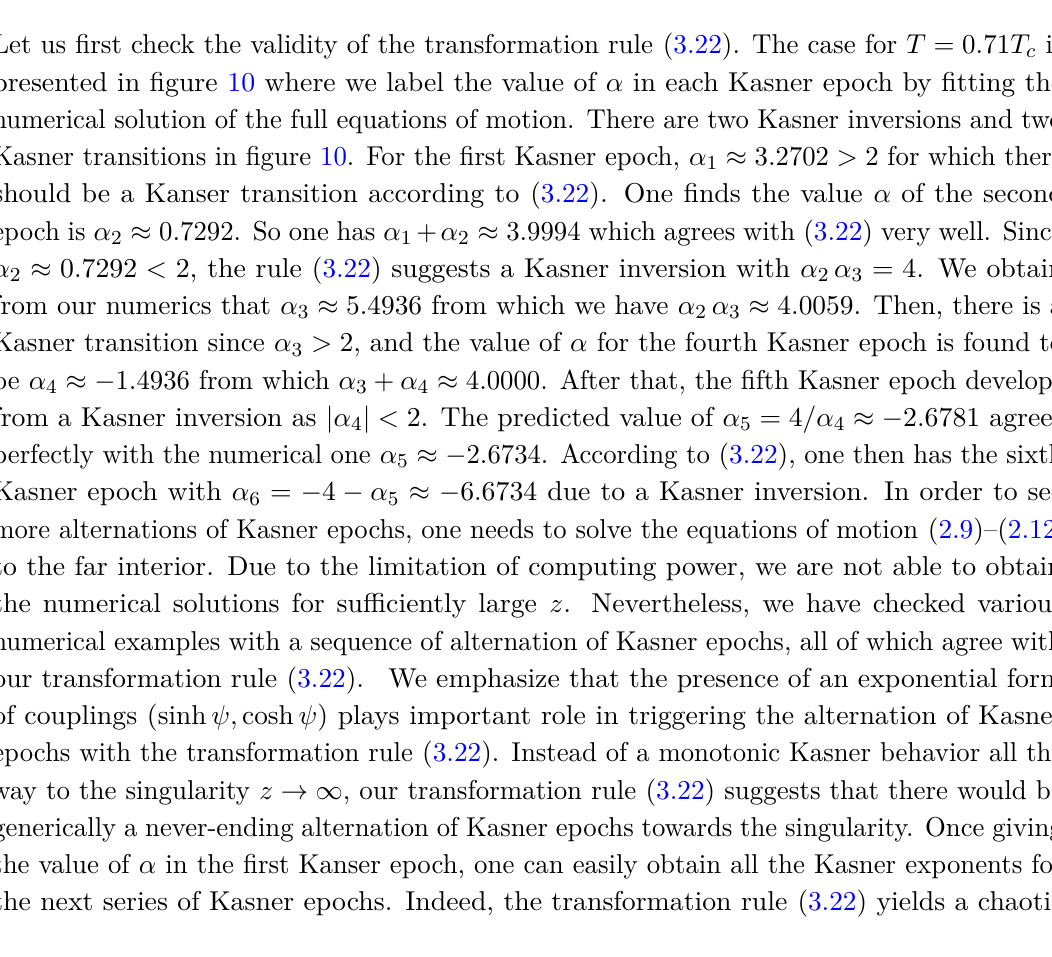
Figure 9 . A comparison of the analytical description (3.18) (dashed blue curve) and the full numerical solutions (solid red curve) for Kasner inversion. We choose T = 0 . 71 T value of α = zψ 0 for each Kanser epoch. The approximation (3.12) is in good agreement to the numerical solution of the full equations of